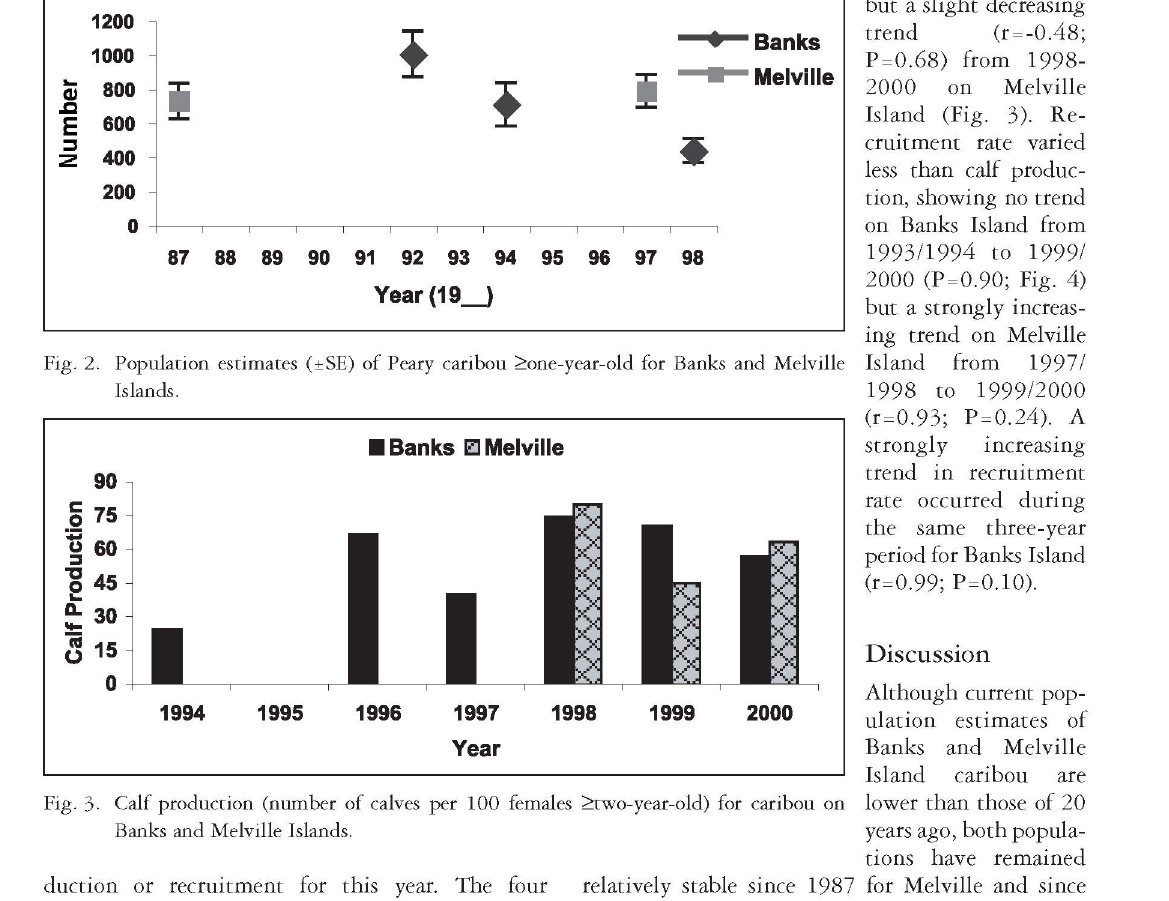
Fig. 3. Calf production (number of calves per 100 females >two-year-old) for caribou on Banks and Melville